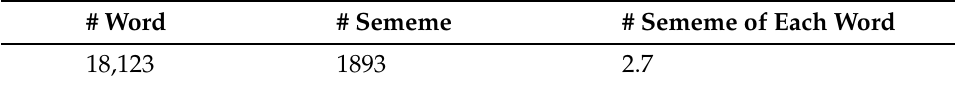
Table 3. The overview of the extracted sememe